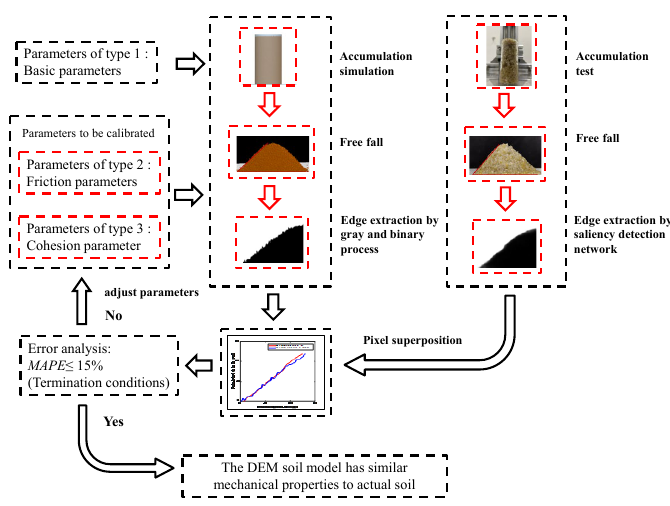
Figure 4. Flow chart of parameters calibration in test and simulation.